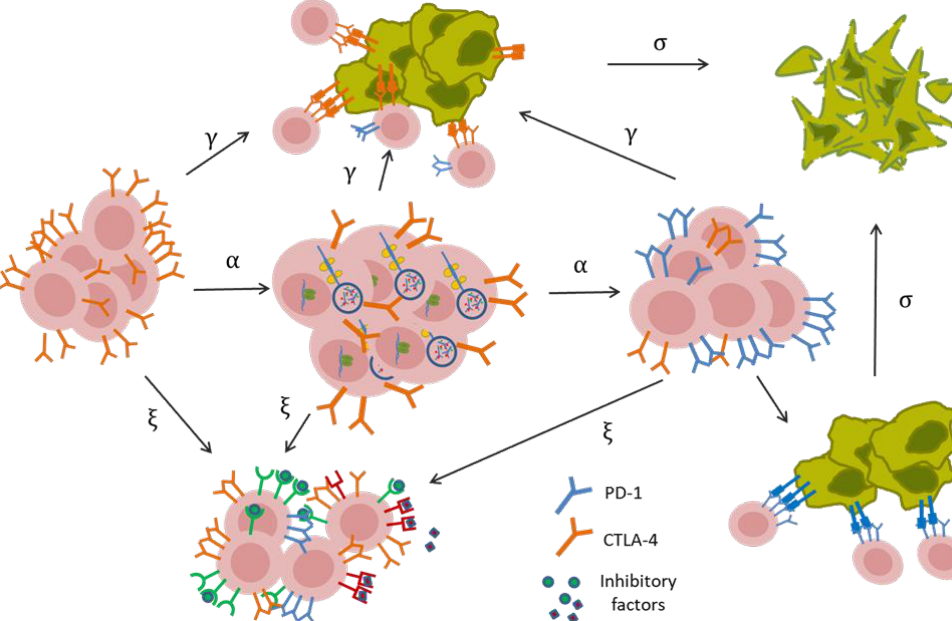
Figure 2. Illustration of the relationships between the components of the mathematical model . PD-1 and CTLA-4 receptors and other factors suppress lymphocyte activity in the tumor microenvironment. As a result of the cytoplasmic storage of preformed CTLA-4 molecules, the total population of active lymphocytes can express the CTLA-4 receptor with no time delay and can be potentially inactivated by this receptor at a gamma rate. Other inhibitory factors can also suppress lymphocytes, independent of PD-1 receptor signaling. The regulation of PD-1 expression occurs mainly at the genetic and epigenetic levels, resulting in a time delay in immune suppression triggered by PD-1 receptors. Concurrently, the cytotoxic activity of lymphocytes results in the death of tumor cells.